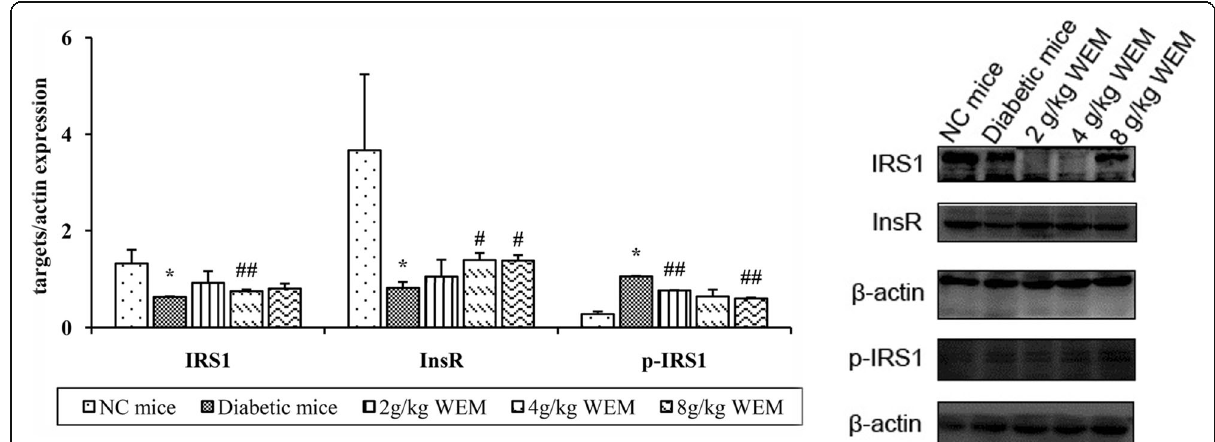
Fig. 10 Protein expression of IRS1 and InsR influenced by WEM in adipose tissue of diabetic mice. A significant elevation of IRS1 and InsR was observed. The effect of WEM on phosphorylation of IRS1 (p-IRS1). An obvious reduction in p-IRS1 was observed among the treatment groups. Data are shown as means ± SEM ( n = 3). * P < 0.05, **P < 0.01, NC mice vs. Diabetic mice; # P < 0.05, ## P < 0.01, WEM vs. Diabetic